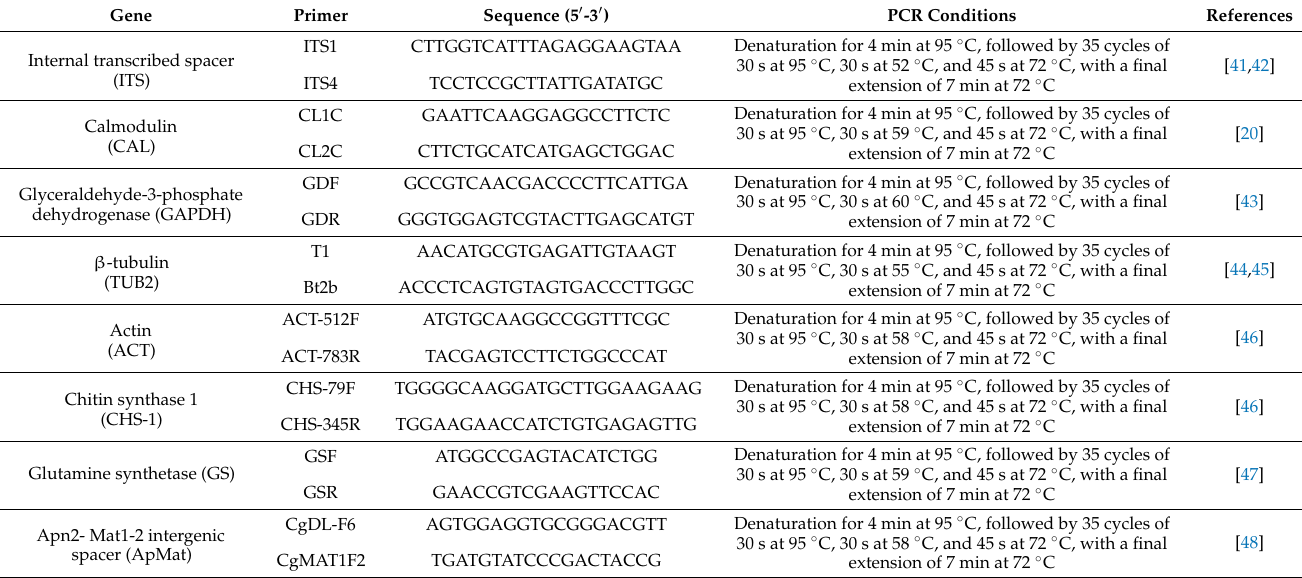
Table 1. Primers used in this study, with sequences, PCR conditions, and